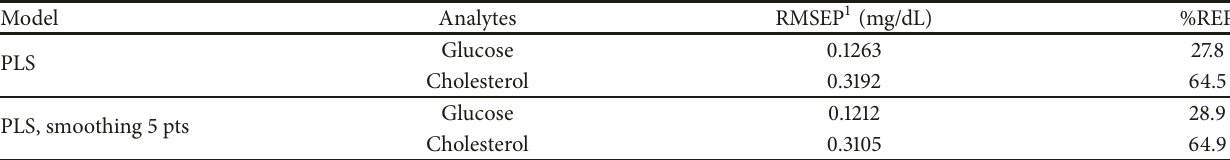
Table 2: Errors obtained between nominal concentrations and estimated by PLS.